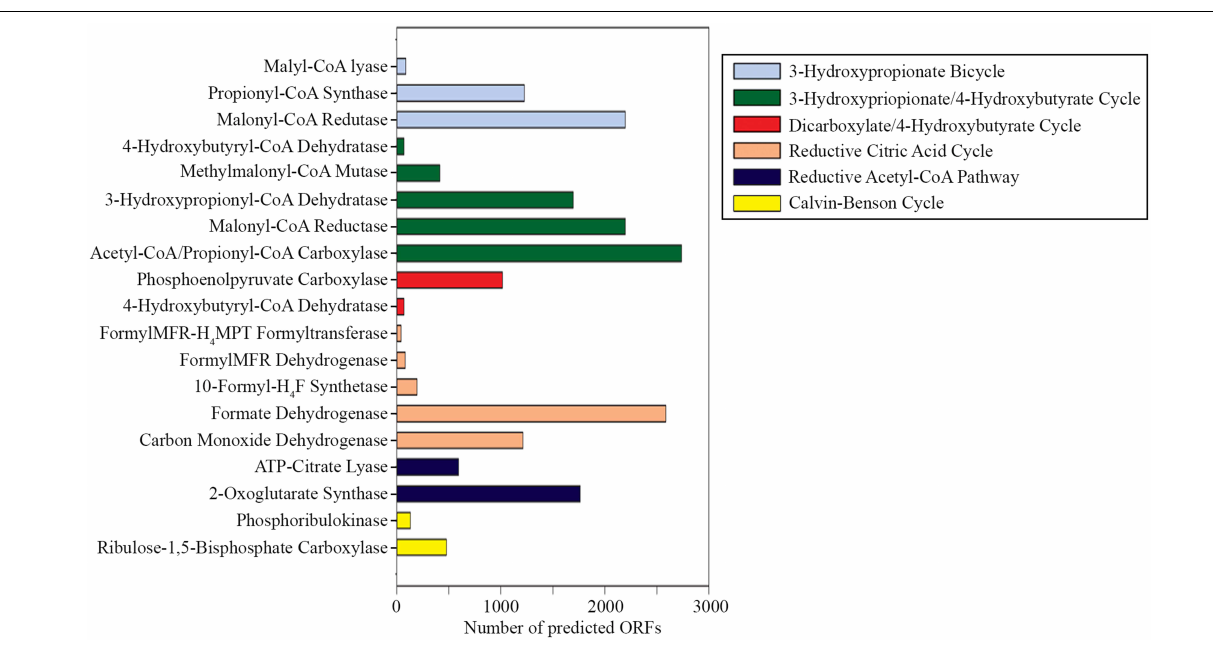
Frontiers in Microbiology |